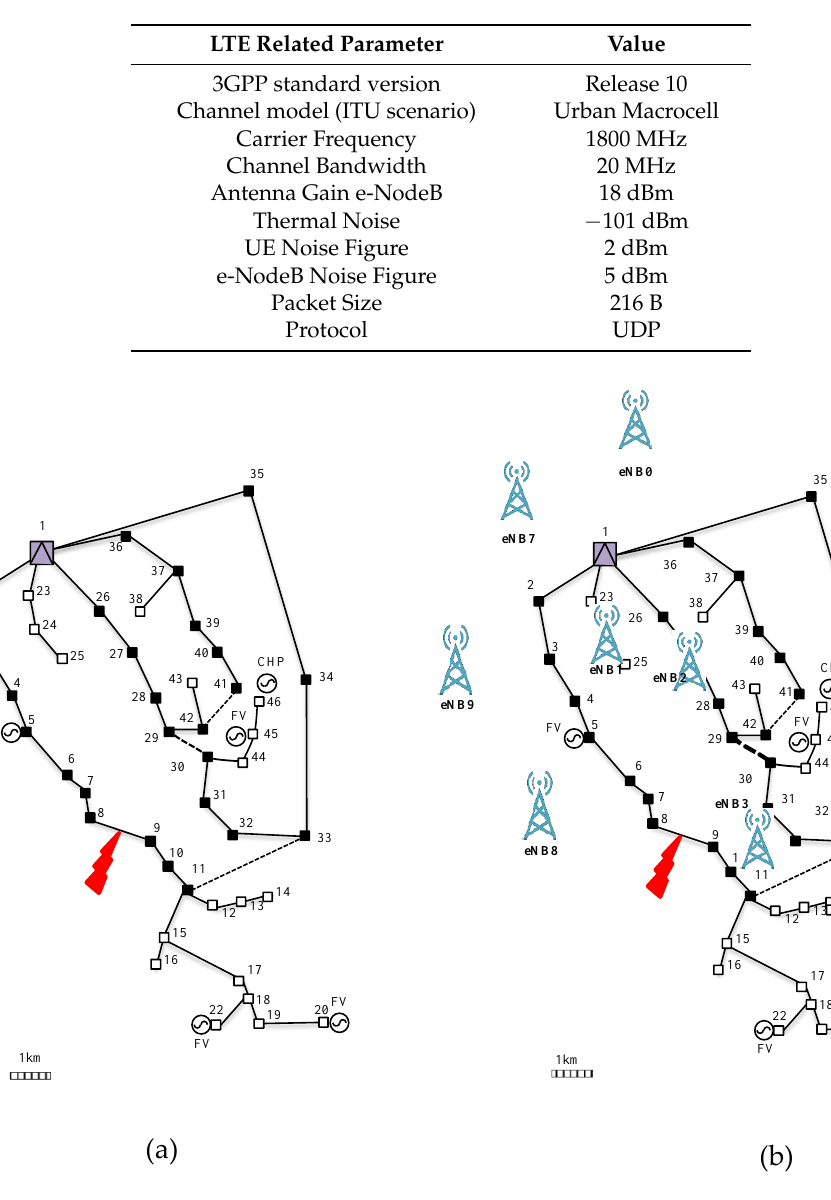
Table 1. LTE communication network parameters.